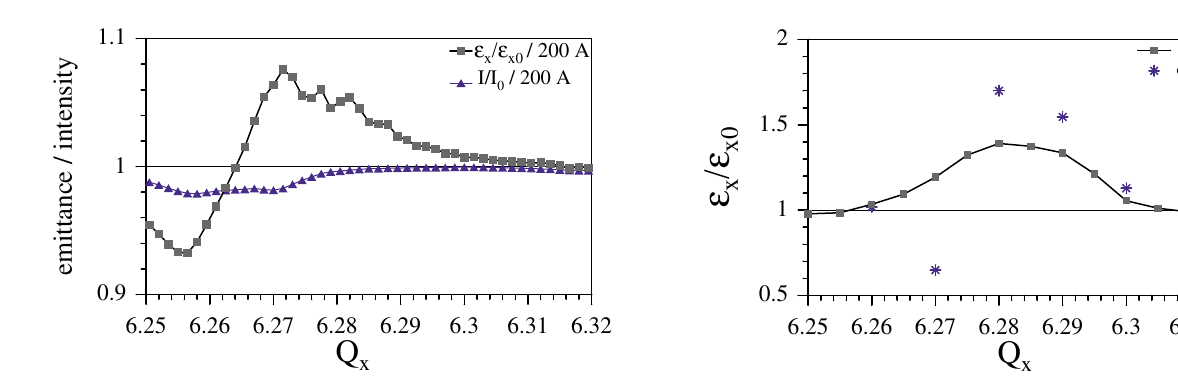
FIG. 5. (Color) 3D simulation using analytical space charge (40 A octupole). Shown are simulated rms emittances (Gaussian fit) after 5 (cid:1) 10 5 turns and experimental values.